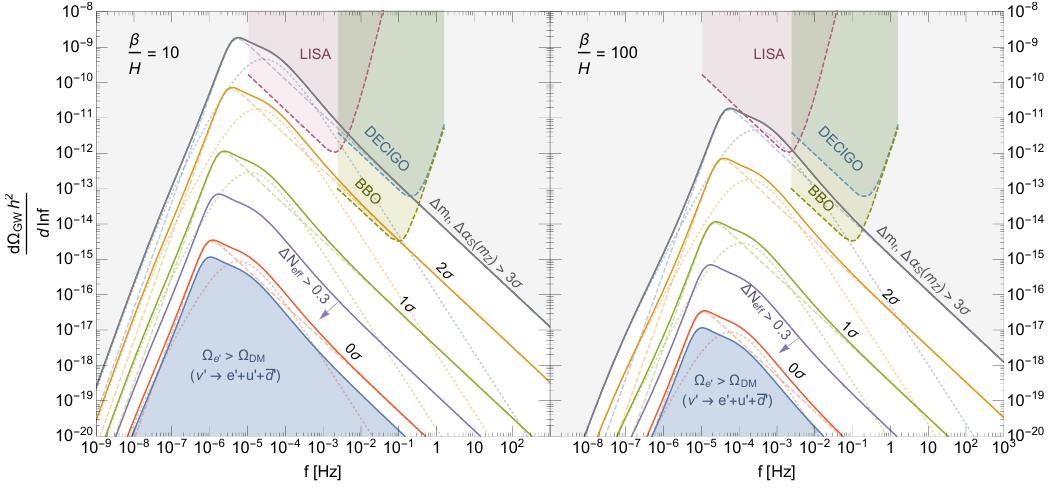
Figure 14 . Gravitational wave spectrum generated by the mirror QCD phase transition for (cid:12)=H = 10 (left) and (cid:12)=H = 100 (right). Future gravitational wave detectors such as LISA and BBO may detect a signal if m t and (cid:11) S ( m Z ) lie more than 2 (cid:27) away from their current central values. phase transition, (cid:26) kin is the kinetic energy of the bubble wall and (cid:26) SM is the energy density of the SM bath, all of which are evaluated at the phase transition. Lattice calculations show (cid:26) lat =(cid:26) g 0 is (1), and so we approximate this ratio as unity [54]. Likewise, we expect O (cid:26) kin is comparable to (cid:26) g 0 as is the case for a weakly coupled, relativistic transition, and so we take (cid:26) kin =(cid:26) lat = 1 [55]. g dec and g 0 are the degrees of freedom of the SM and dec